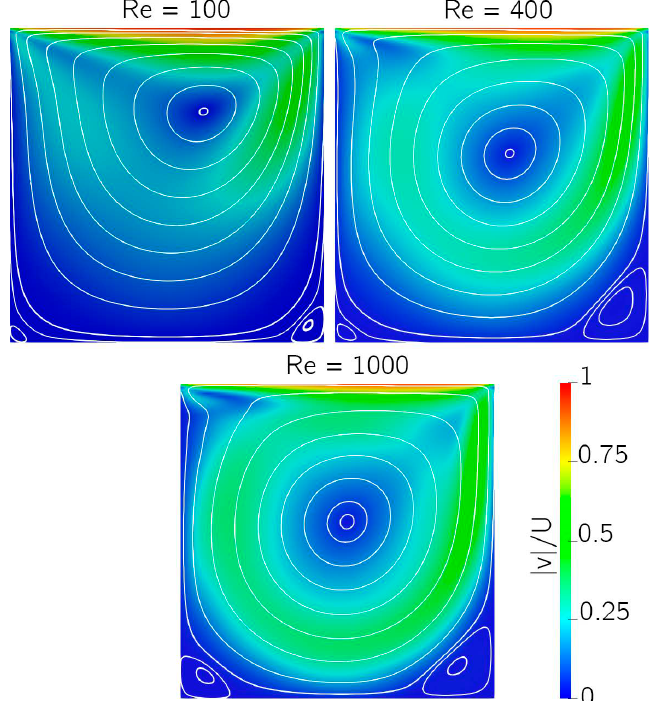
Figure 23. Contours of velocity and streamlines for lid driven cavity at different Re numbers. Re = 100 ( top left ), Re = 400 ( top right ), and Re = 1000 ( bottom